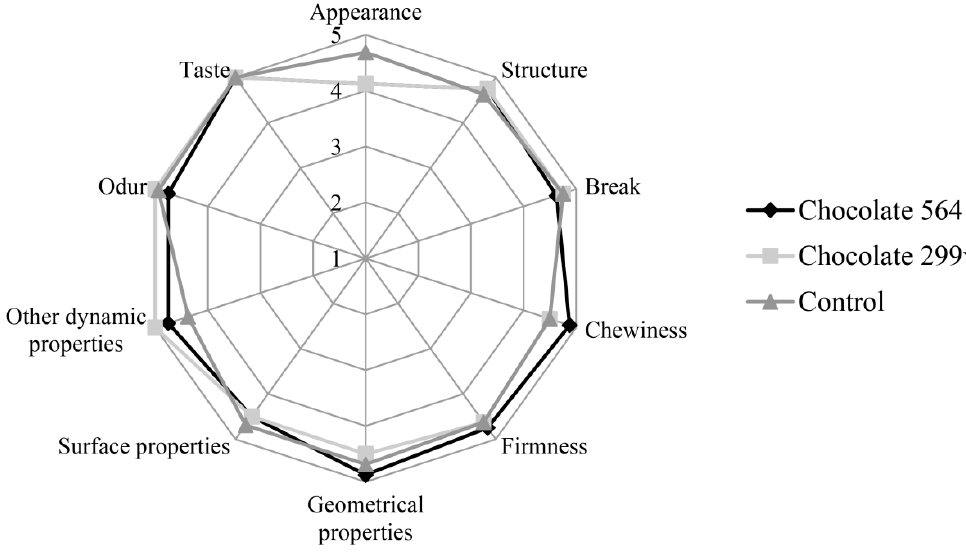
Figure 4. Sensory evaluation of dark chocolates with probiotic bacteria after 180 days of storage at 20°C.